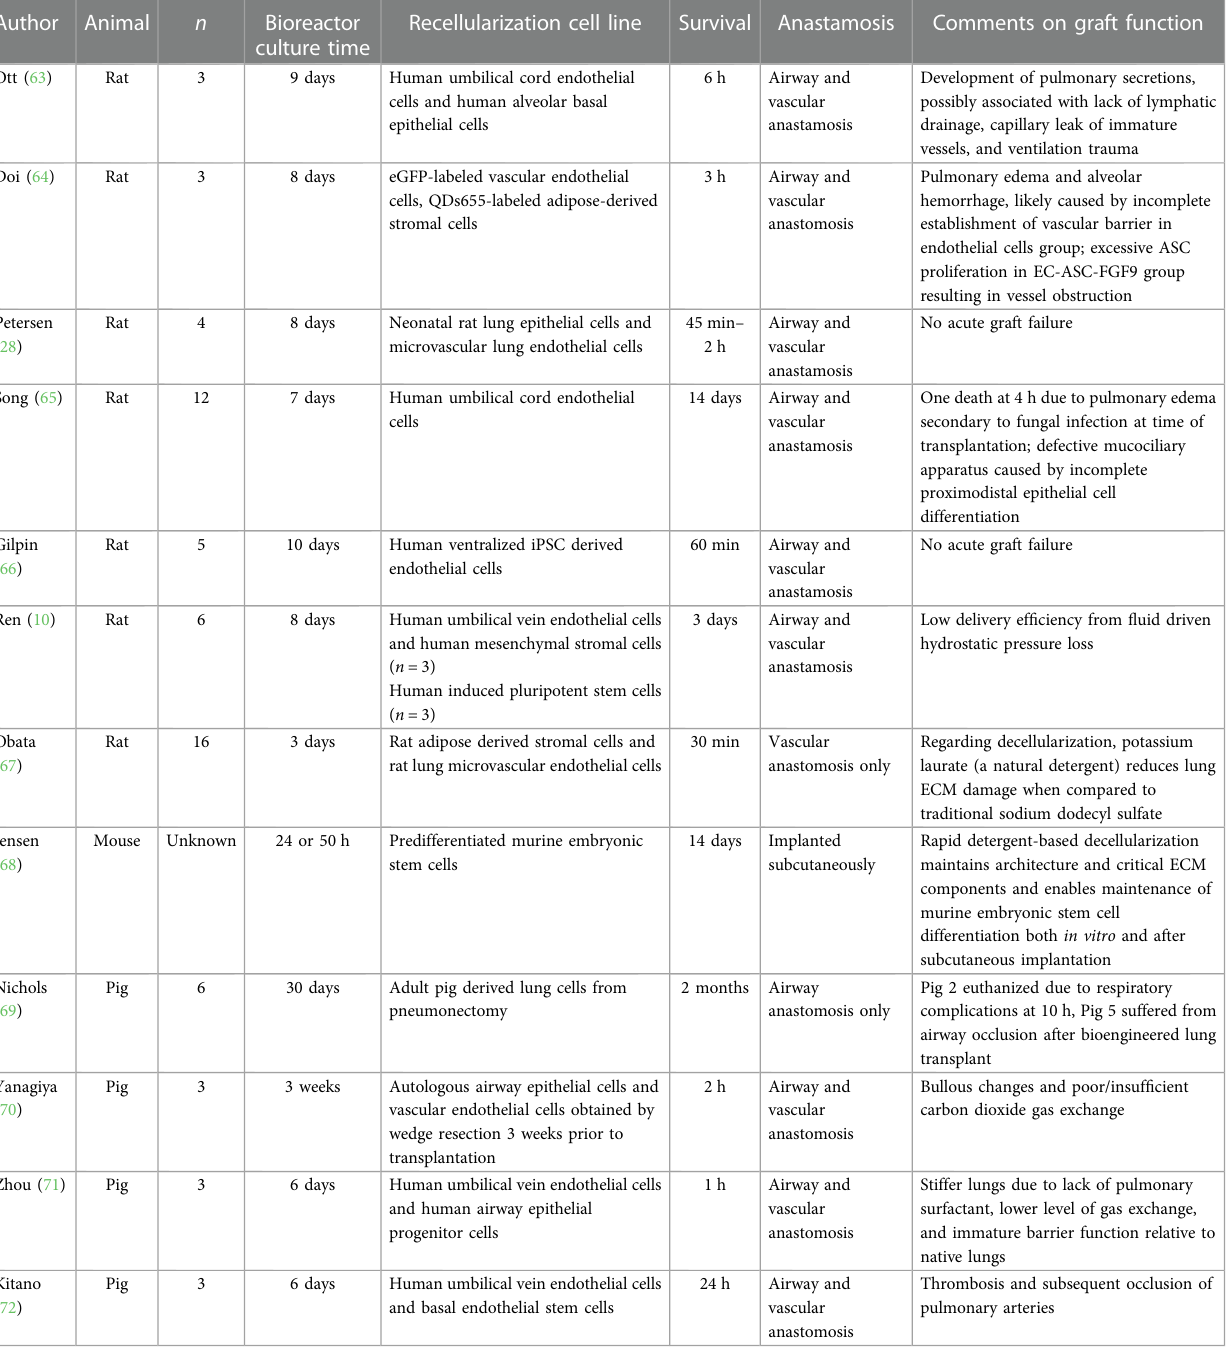
TABLE 1 Summary of bioengineered animal transplantation experiments and